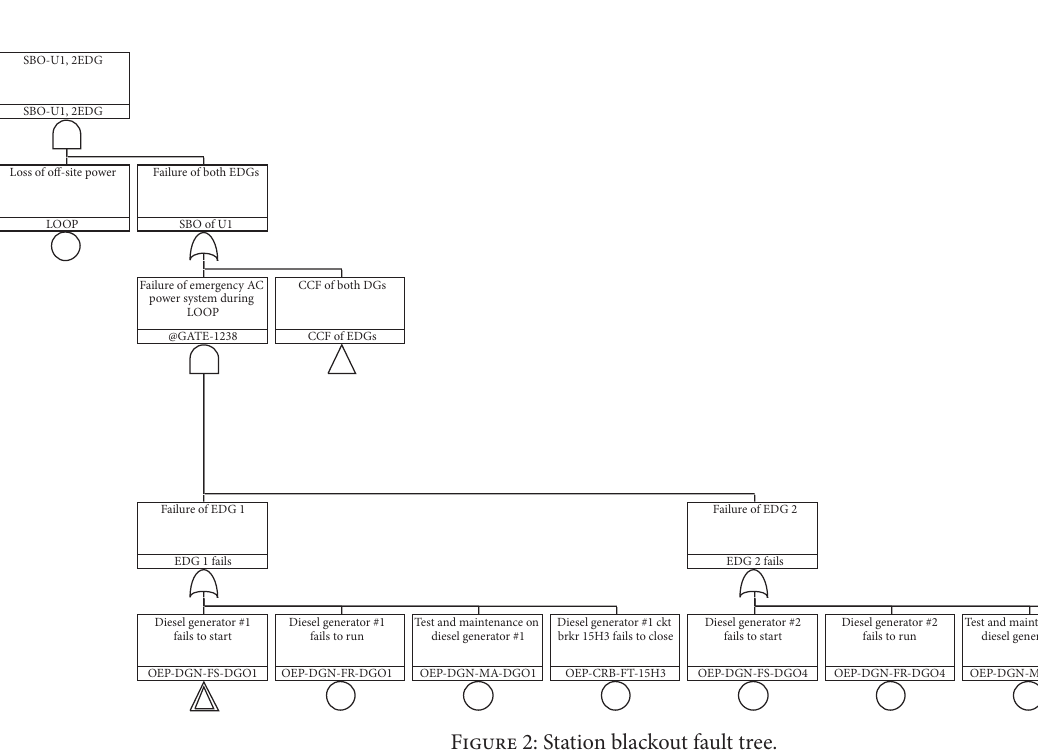
Figure 2: Station blackout fault